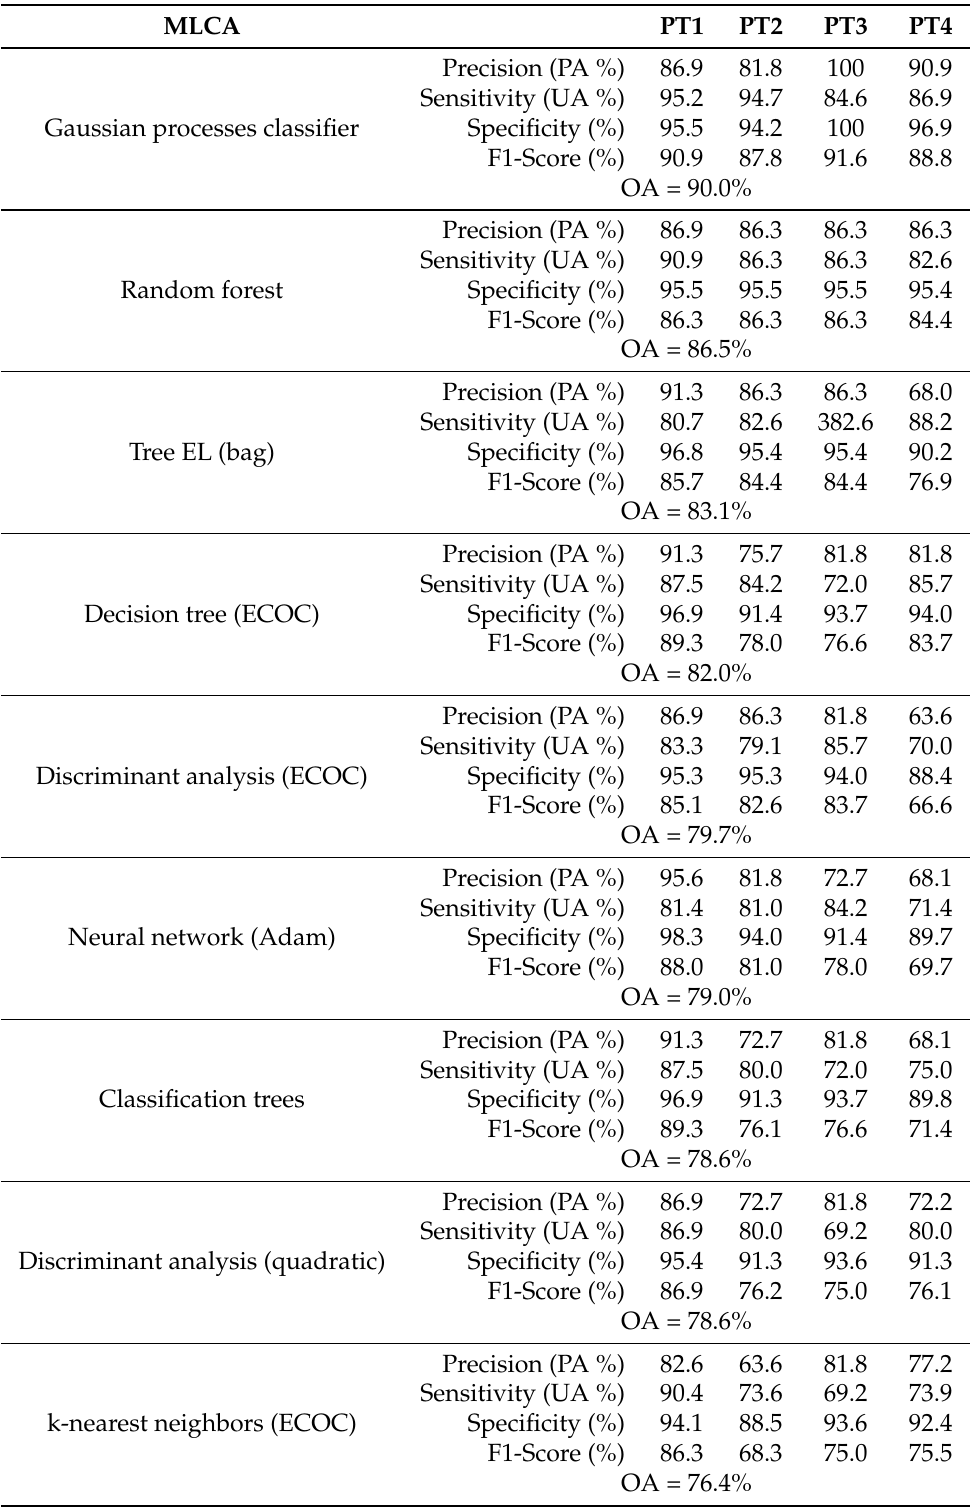
Table 3. Accuracy results against validation data for all MLCAs. Results are ordered from best overall accuracy (OA) to